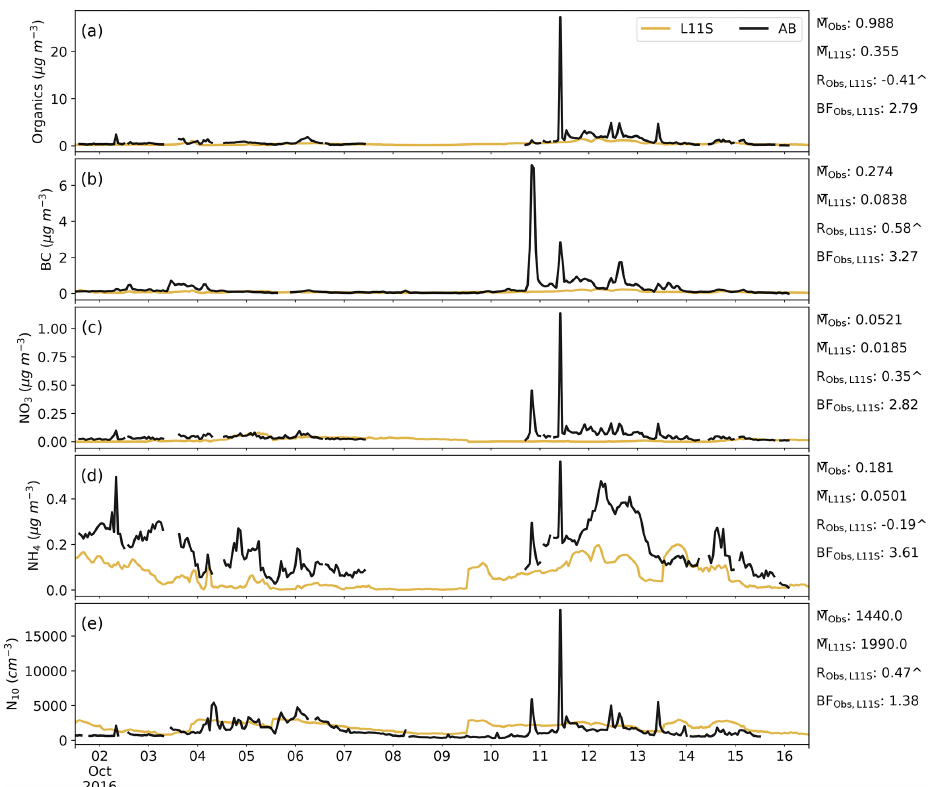
Figure C4. Time series for AIRBOX in descending order of surface organic, BC, NO 3 and NH 4 aerosol mass and aerosol number greater than 10nm ( N 10 ), comparing the L11S simulation (yellow) to the observations (black). Summary statistics are shown for the observations and L11S including the mean ( M ), the Pearson correlation ( R ) and the normalised mean bias factor. ∧ indicates where the R values are significant to the 95th